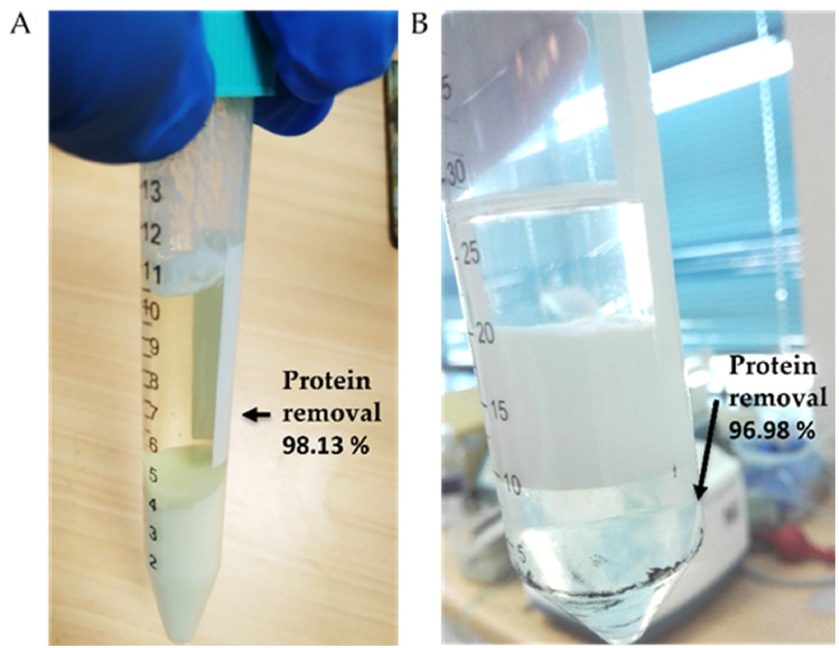
Figure 6. Phases and protein removal resulting from raw milk clarification using ( A ) the Carrez reagent and ( B ) ethyl